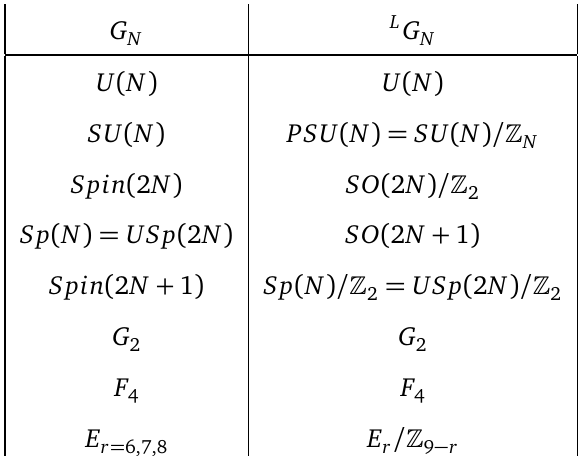
Table 1: Langlands / GNO relation between classiical Lie groups and their dual